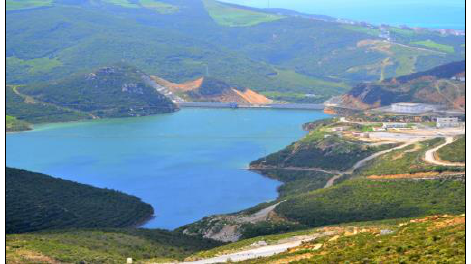
Figure 1 . Tanger-Med dam in the north of Morocco.